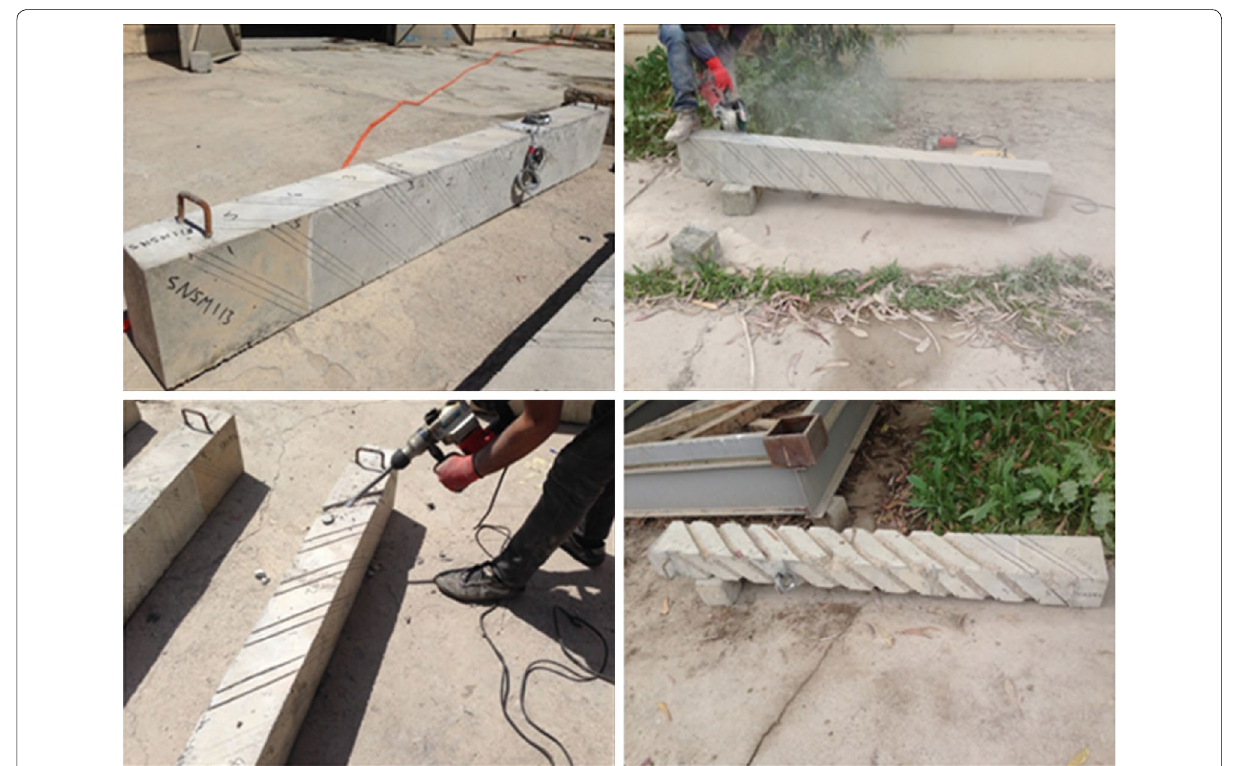
Fig. 3 Continuous spiral NSN groove